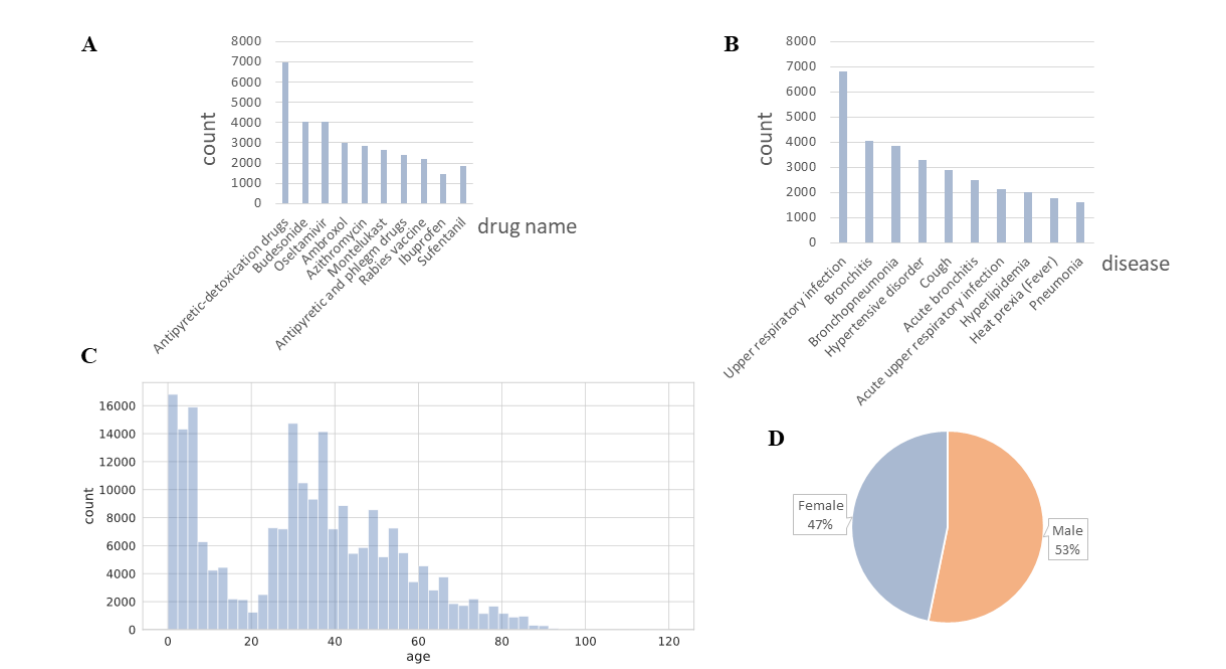
Figure 12. Statistical overview of claim documents: (A) top 10 drug names in claim documents; (B) top 10 diseases occurring in claim documents; (C) age distribution in claim documents; (D) sex ratio in claim documents.